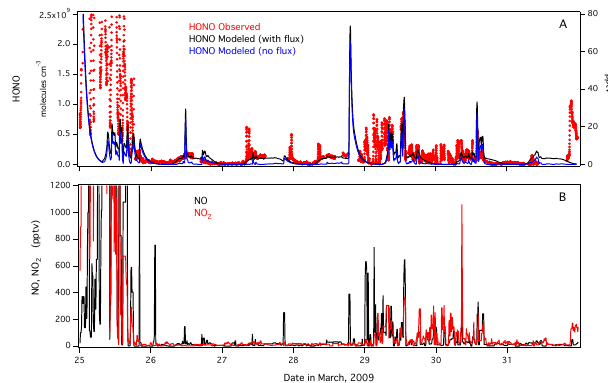
Figure 3. (a) Time series of in situ HONO observations (red data) and modeled HONO including an additional flux (black trace) and without an added flux (blue data). (b) Time series of observed NO (black trace) and NO 2 (red trace) that has been re-scaled to a smaller range on the y axis to show the relatively higher NO x mole ratios on 29 and 30 March.